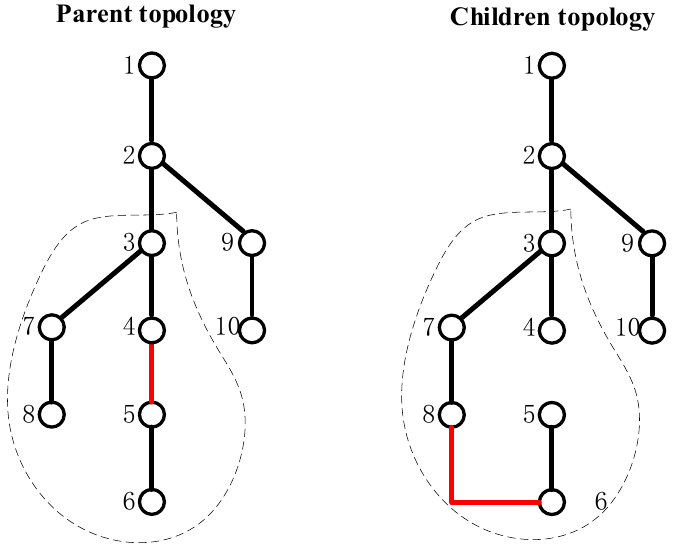
Figure 3. Mutation operation of network topology.